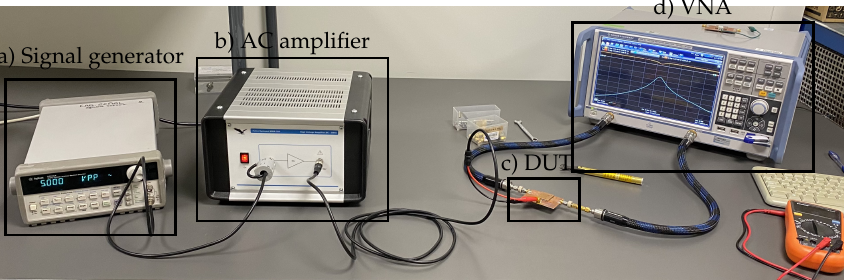
Figure 8. Measurement setup: ( a ) Signal generator, ( b ) AC voltage amplifier, ( c ) Device Under Test (DUT) and ( d ) Vectorial Network Analyzer